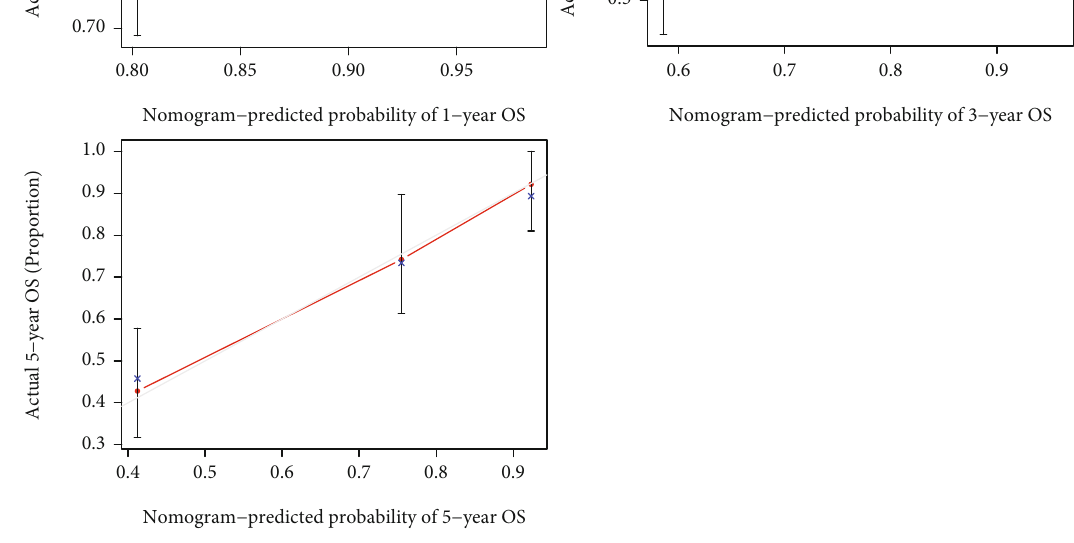
Figure 7: Development of the nomogram. (a) Nomogram using ceRNA expression levels and corresponding clinicopathological features for predicting the proportion of OS in CRC patients. (b) Calibration curve for predicting patient survival at 1 year, 3 years, and 5